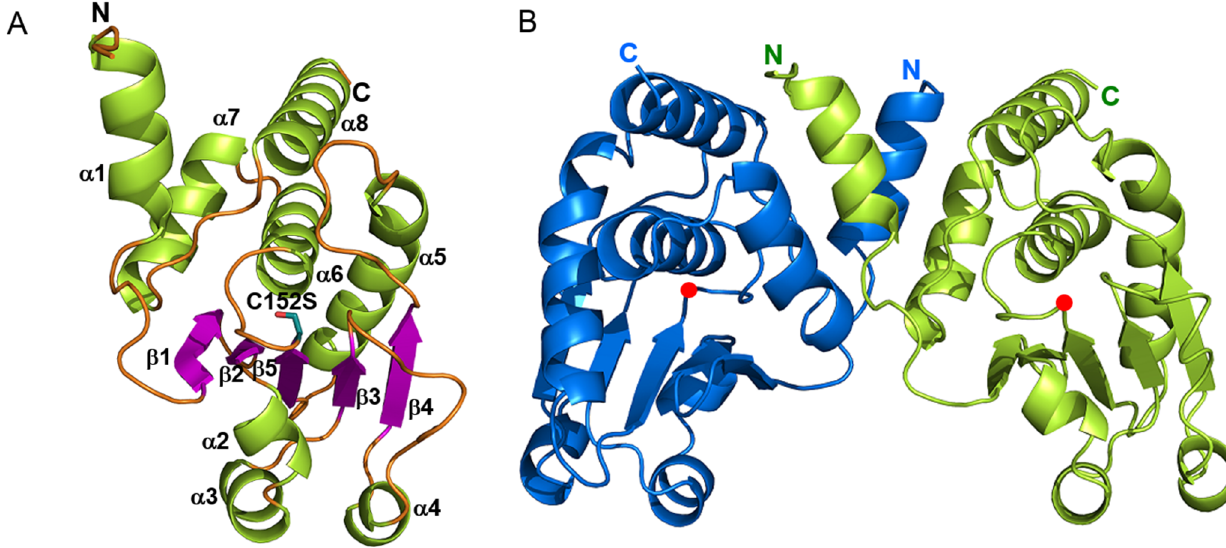
Fig 2. Overall structure of DUSP26-N (C152S). (A) A ribbon model of the monomeric DUSP26-N (C152S) structure. Secondary structural elements are labeled. (B) A ribbon model of the dimeric DUSP26-N (C152S) structure. Chains A and B of DUSP26-N (C152S) are colored blue and green, respectively. The Ser152 residue is shown as a red dot. The N- and C-termini are labeled.